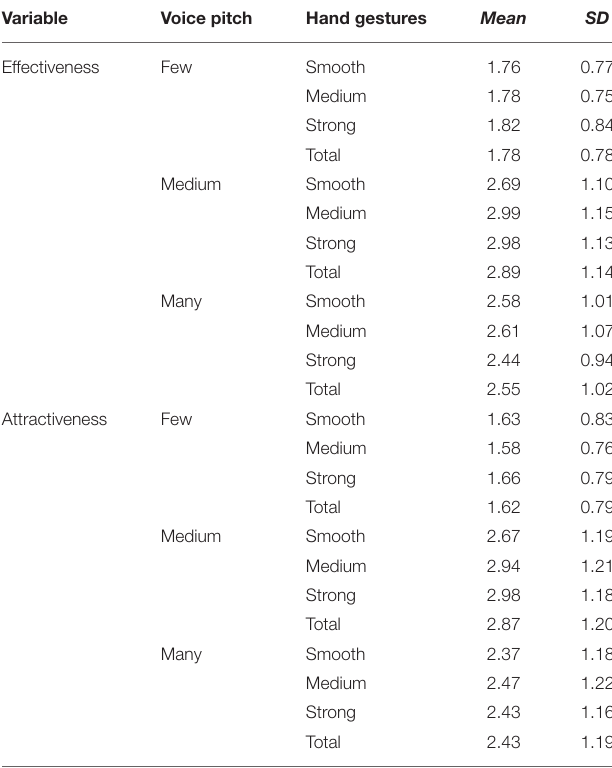
TABLE 1 | Effectiveness and attractiveness of voice pitch and